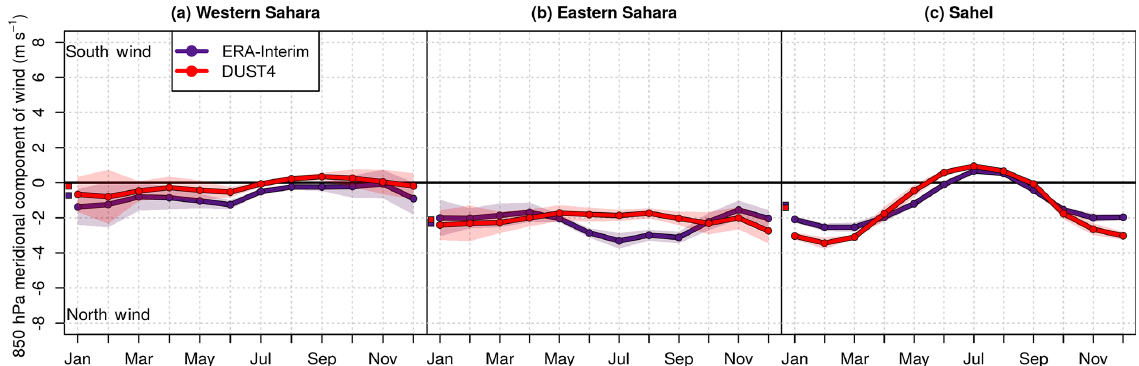
Figure 8. Annual cycle of the meridional wind component of ERA-Interim and DUST4 experiment for the period December 2006 to November 2014. Positive and negative values indicate south and north wind, respectively. Shaded areas represent the 95% confidence interval of the